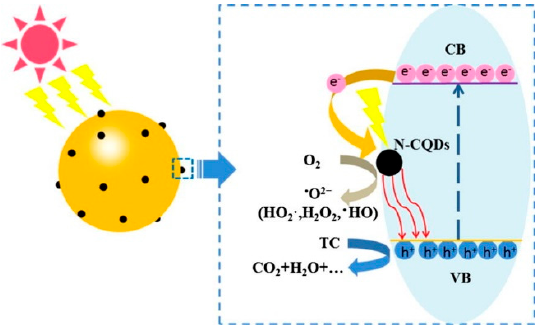
Figure 5. Graphical illustration of possible photocatalytic reaction mechanism of the nitrogen-doped CDs/Bi 2 WO 6 composite. Figure adapted from reference [101].